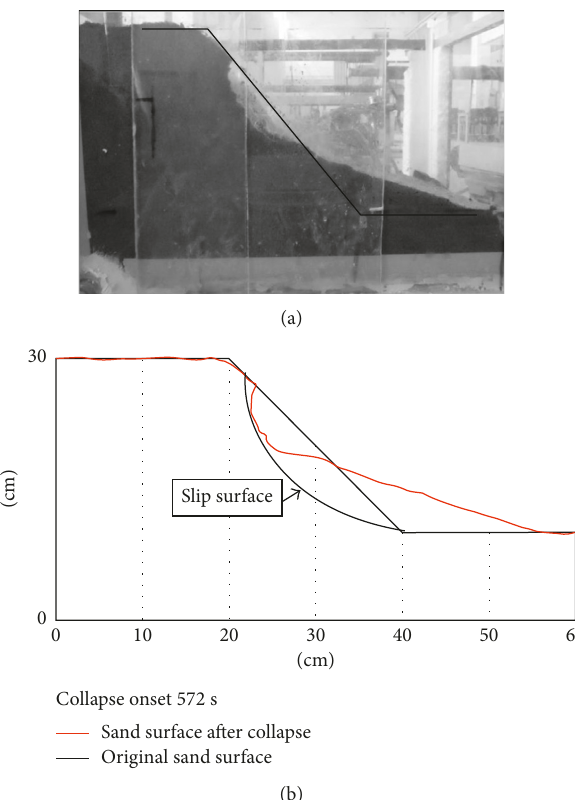
Figure 7: Side view of sand slope after collapse in Experiment 1 (varied soil density). (a) Changes of slope surface. (b) Displacement of slope before and after collapse.